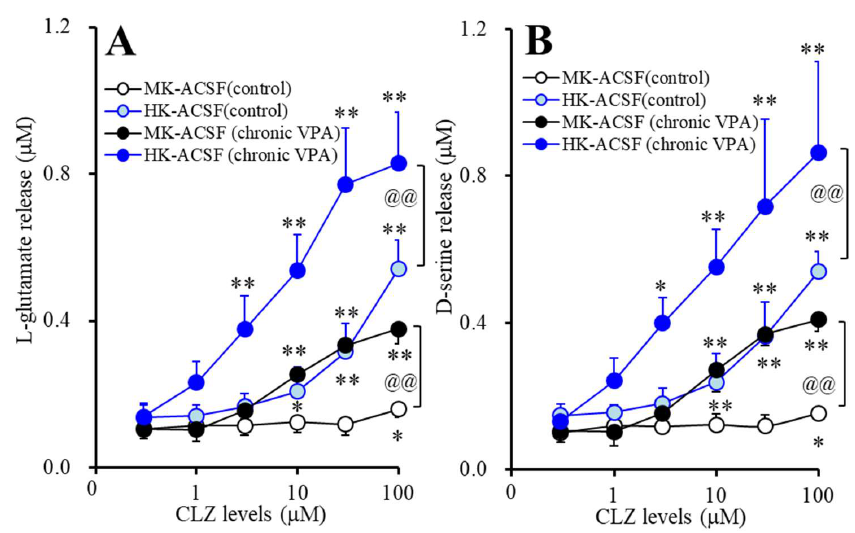
Figure 5. Acute effects of CLZ on astroglial releases of L-glutamate (A) and D-serine (B) from astrocytes subchronically administrated with therapeutic-relevant concentration of VPA (1000 μ M). Astrocytes were incubated in fDMEM without (control: opened circles) or with VPA (1000 μM: closed circles). After wash-out, astrocytes were incubated in ACSF containing the same concentration of VPA with CLZ (0, 1, 3, 10, 30, 100 μ M) for 60 min (pretreatment incubation). After pretreatment incubation, to determine the K + -evoked astroglial releases of L-glutamate and D-serine, astrocytes were incubated in MK-ACSF (50.0 mM K + : black circles) or HK-ACSF (100.0 mM K + : blue circles) containing the same concentration of CLZ and VPA during pretreatment incubation for 20 min, and then incubate medium (MK-ACSF or HK-ACSF) was collected for analysis. Ordinate: mean ± SD ( n = 6) of extracellular levels of L -glutamate and D -serine (μM). Abscissa: concentration of CLZ ( μ M). * p < 0.05 and ** p < 0.01 vs. CLZ free, and @@ p < 0.01 vs. VPA free (control) by MANOVA with Tukey’s post hoc test.